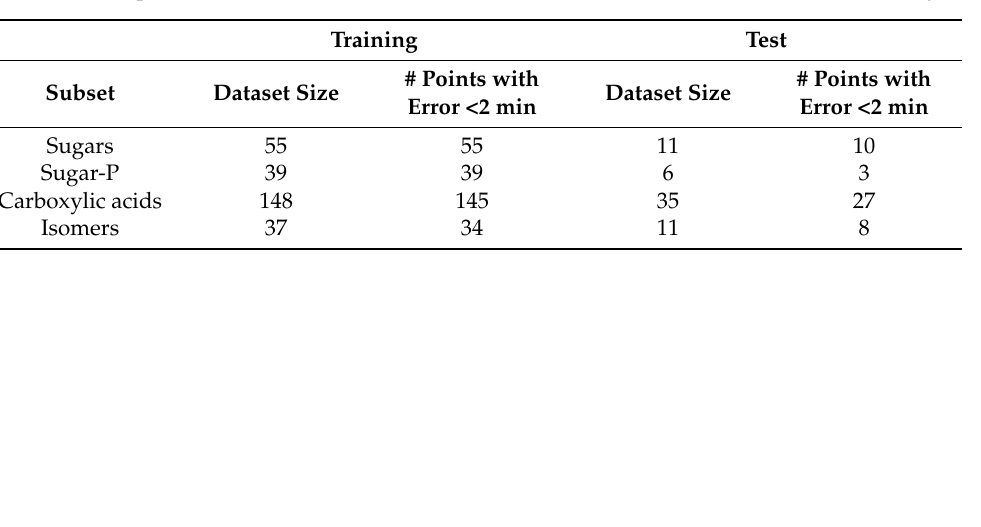
Table 2. Model performance on selected subsets of metabolites detected from the MSMLS